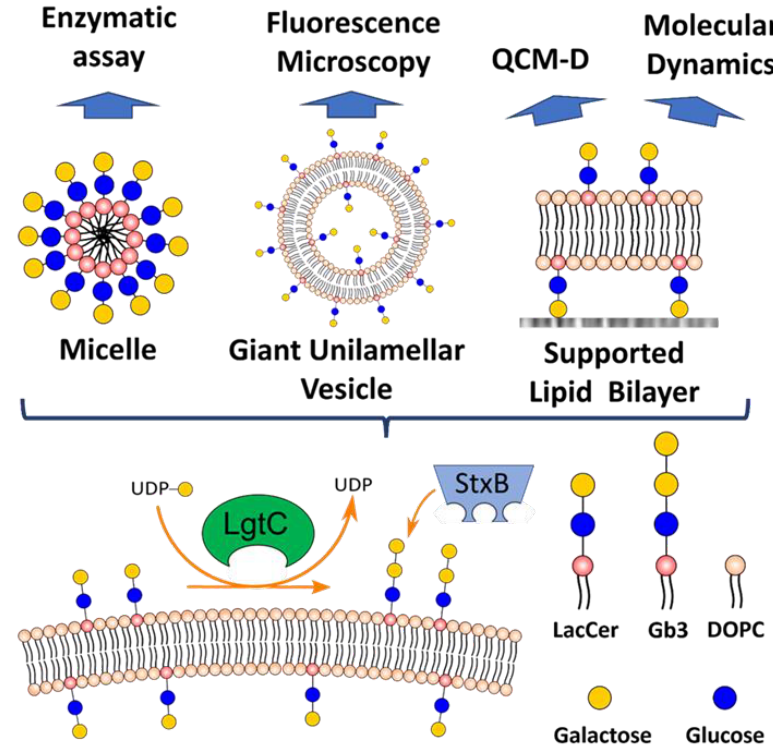
Figure 1. Overview of the LgtC enzyme reaction, different lipid constructs and the techniques